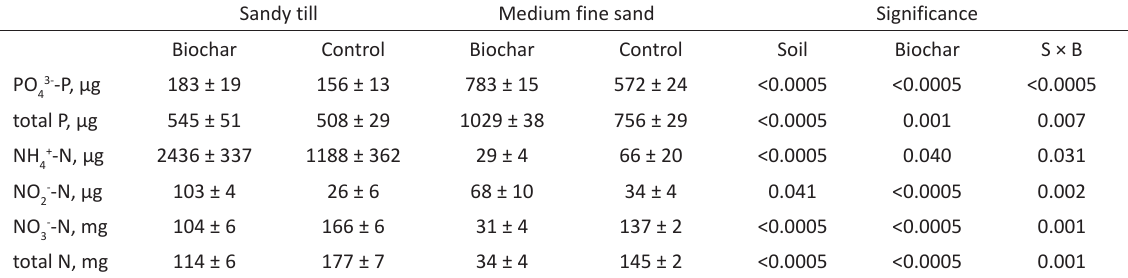
Table 5. Mean (± standard error of mean) amount of leached nutrients during the whole experiment. Soil type (S), biochar treatment (B) and their interaction (S × B) were statistically significant in the case of all nutrient forms. Sandy till Medium fine sand Significance Biochar Control Biochar Control Soil Biochar